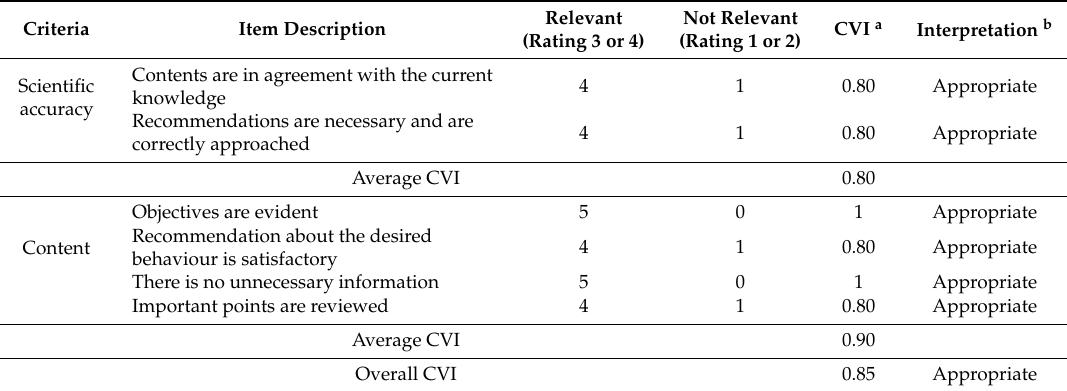
Table 4. Content validity index for physical activity module by expert panel members ( n =